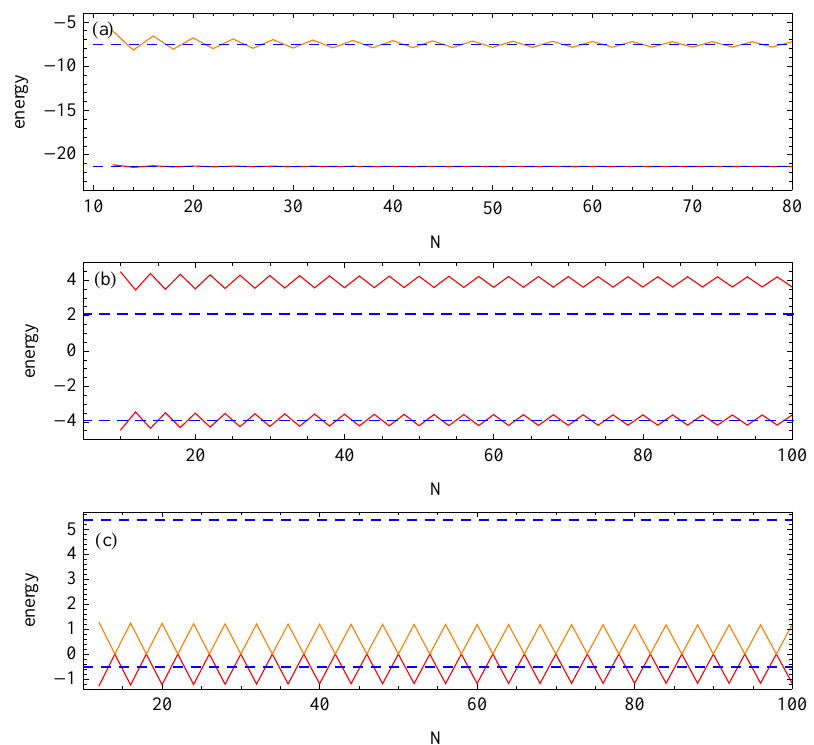
Figure 1. Convergence of the Hill determinant calculation of the first two energy eigenvalues for anomalous cases of the sextic anharmonic oscillator V ( x ) = mx 2 + bx 4 + x 6 . Parameter values are: ( a ) ( m = − 18, b = 0); ( b ) ( m = − 8, b = 0); and ( c ) ( m = − 4, b = 0). The dashed lines show the exact energy values. Case (a) show convergences to the correct values, although extremely slowly. Case (b) shows convergence for both energies, but only the ground state converges to the correct value, while the excited state converges to the wrong value. Case (c) shows complete lack of convergence for both